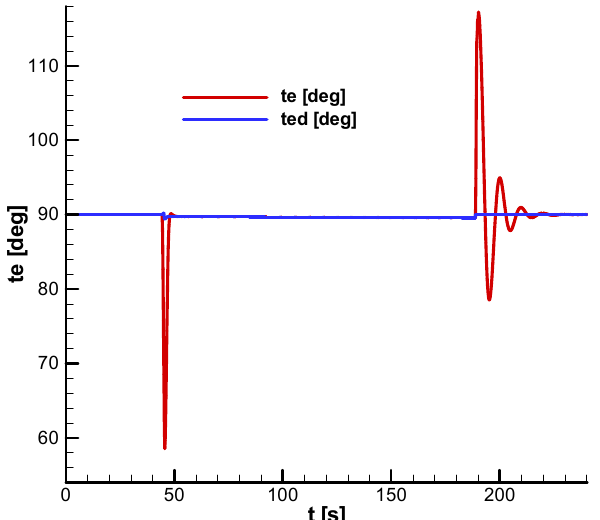
Figure 22. Diagram of the pitch angle: ted —desired pitch angle; te —achieved pitch angle.